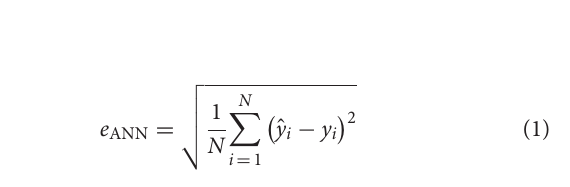
FIGURE 2 | In our multi-fidelity framework we use computational models with different fidelity (accuracy) of one and the same physical system or process. Different fidelity levels can in the context of most computational schemes easily be realized by variations of the discretization length. Finer discretization typically yields more accurate but computationally also more expensive models. Thus, it is favorable to use as many samples as possible at lower fidelity levels in order to pre-train an ANN before a much smaller number of accurate high-fidelity samples is used for fine-tuning the internal parameters of the